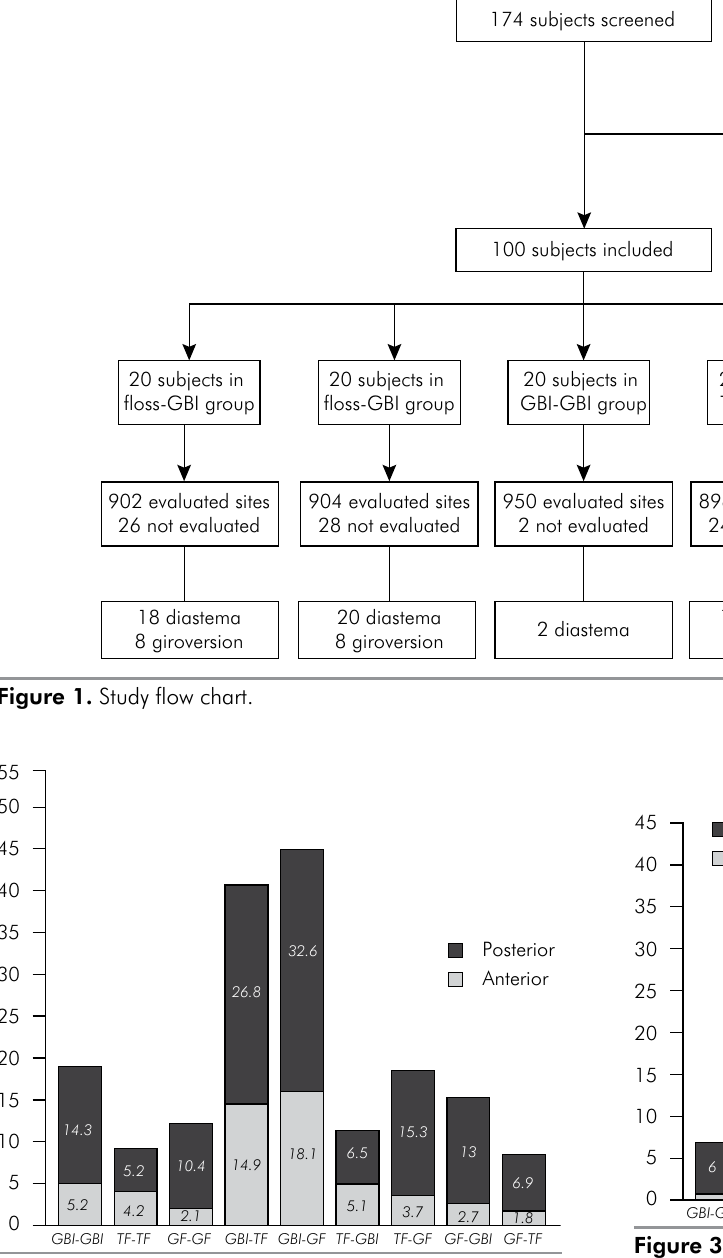
Figure 2. Percentage of non-bleeding sites in the first assessment and bleeding sites in the second assessment according to location in the anterior (incisors and canines) or posterior (premolars and molars) regions. There were statistically significant differences in the frequency of scores between posterior and anterior sites for all sequences (p < 0.05, McNemar’s test).